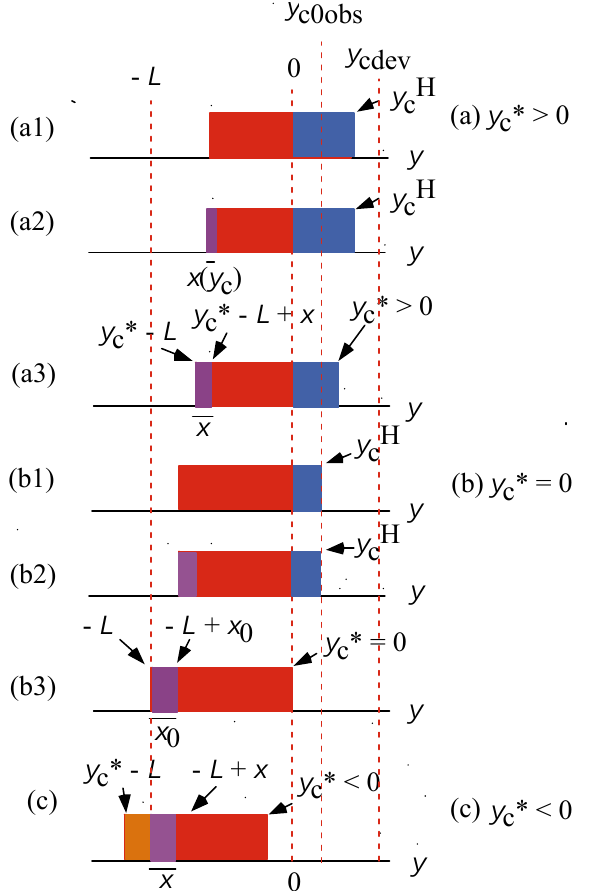
transition by shift of y cH to y *. 12 c < y cH < y c0obs cdev